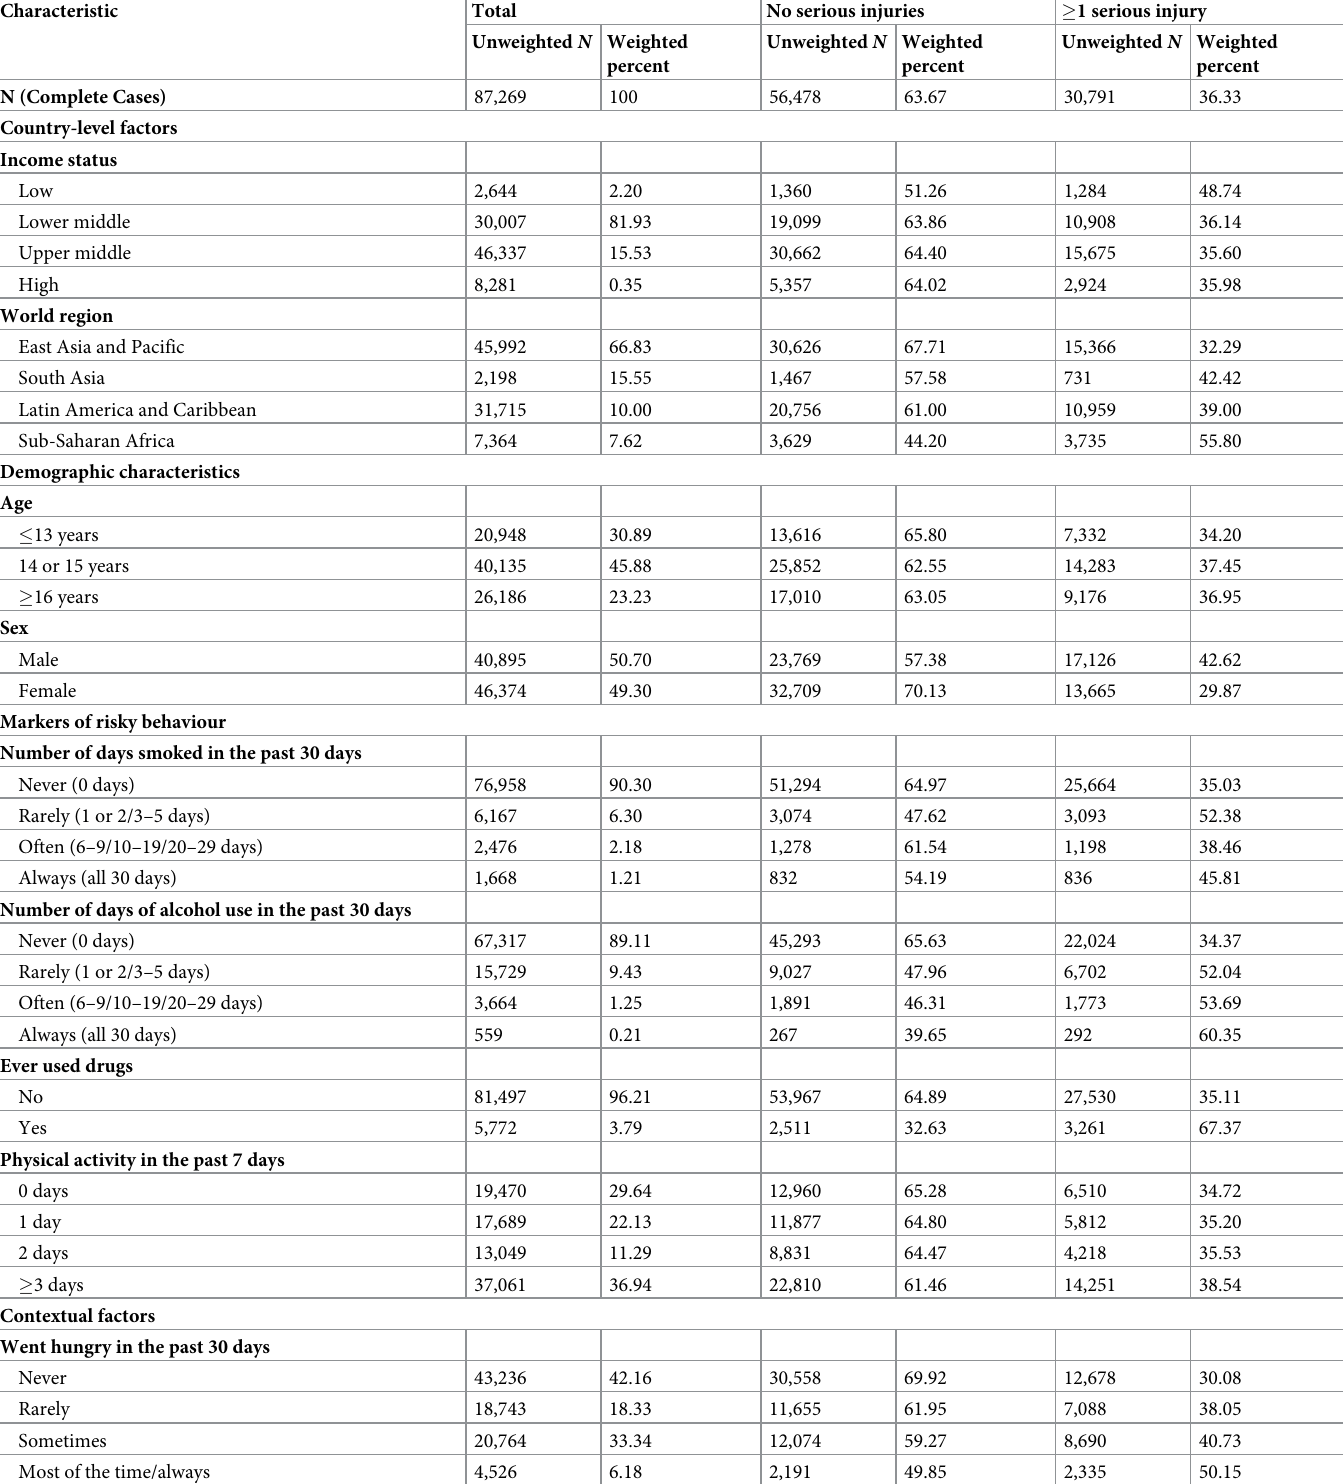
Table 2. Characteristics of the total population and by occurrence of any serious injury in the last 12